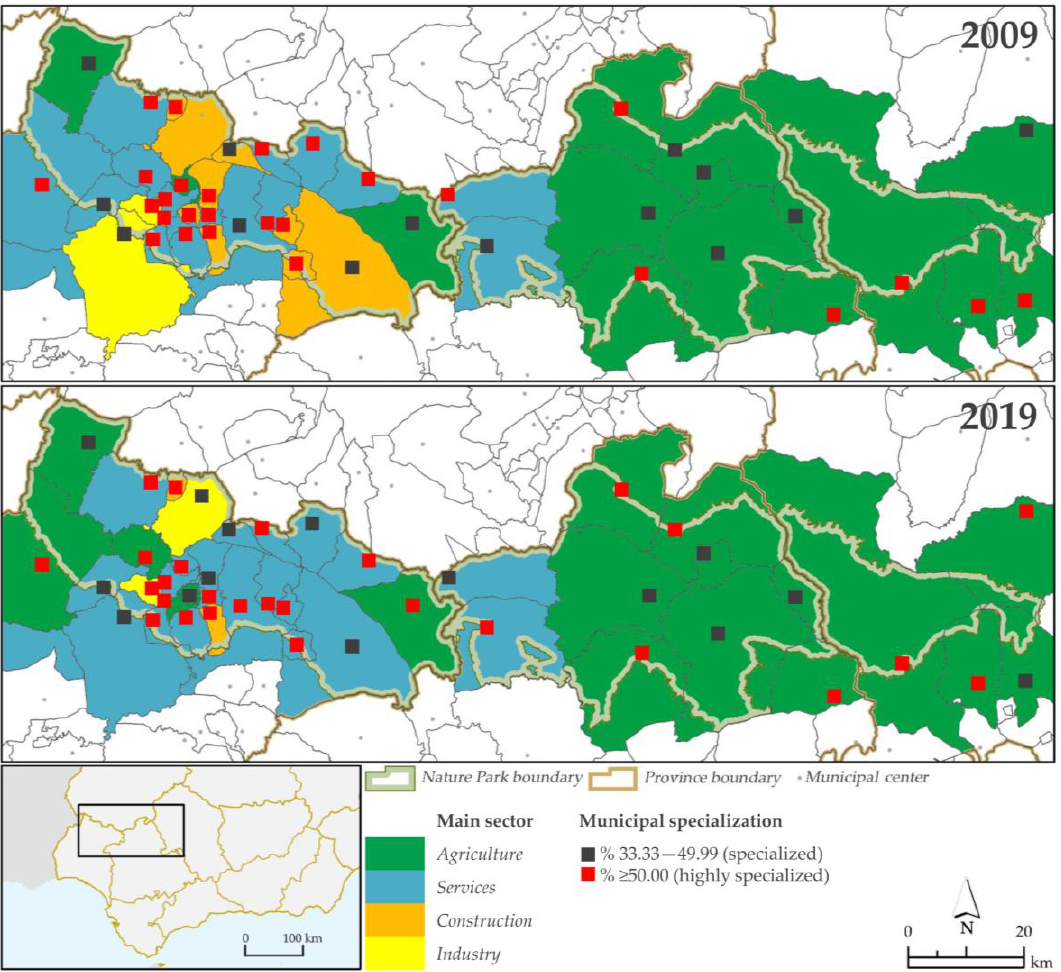
Figure 12. Employment by central activity sector in 2009 and 2019. Source: [85]; authors ’ elaboration.